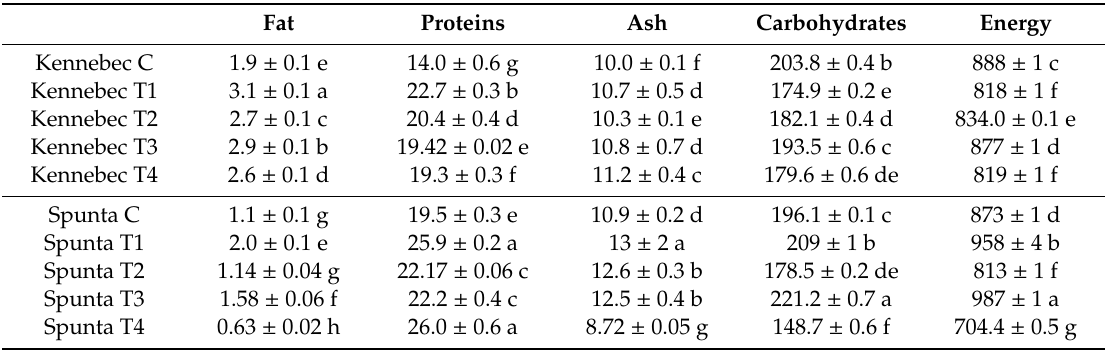
Table 3. Nutritional value (g / kg fw) and energetic value (kcal / kg fw) of the studied potato varieties in relation to the fertilization regime (mean ±